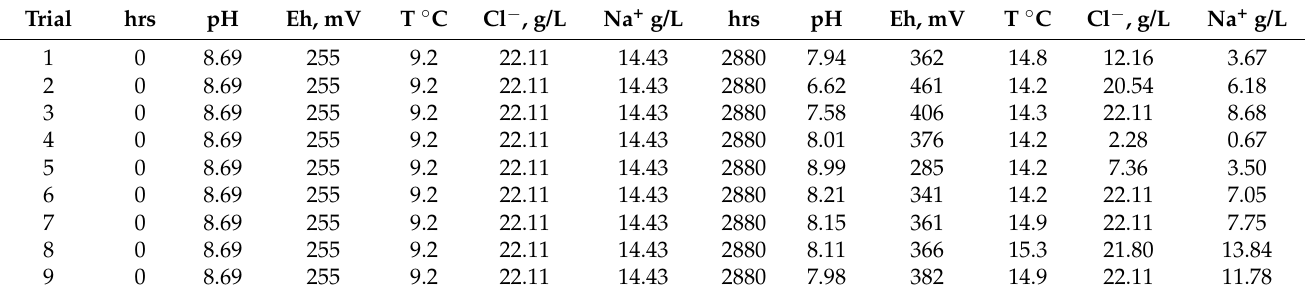
Table A6. Example Water Analyses for Fe(a,b,c)@Ca@HCOOH Polymers which showed no effective desalination after 24 h.